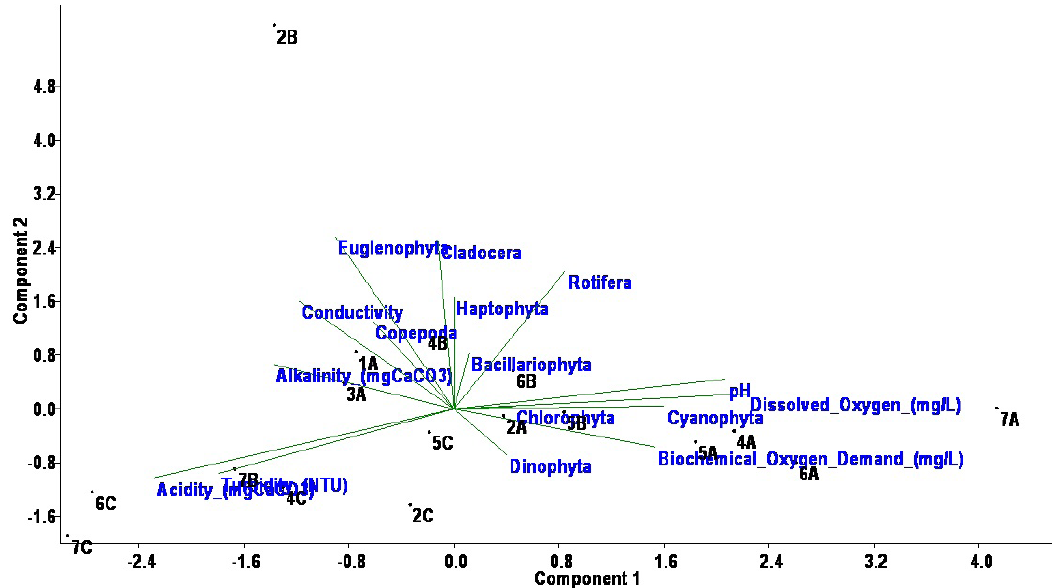
Figure 5. Principal component diagram showing relationship between plankton groups and physico-chemical